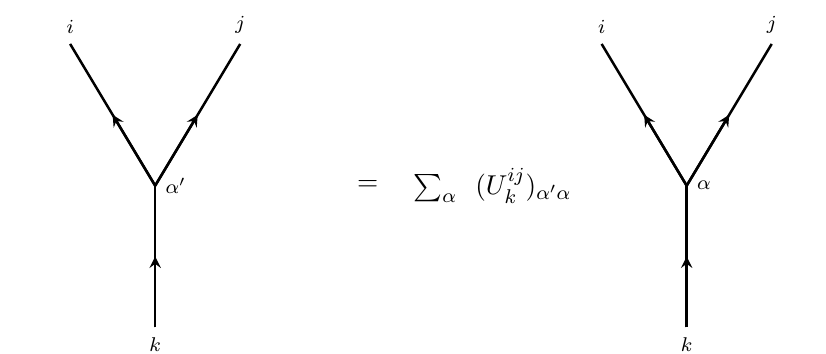
Figure 7 . A change of basis via a unitary matrix.